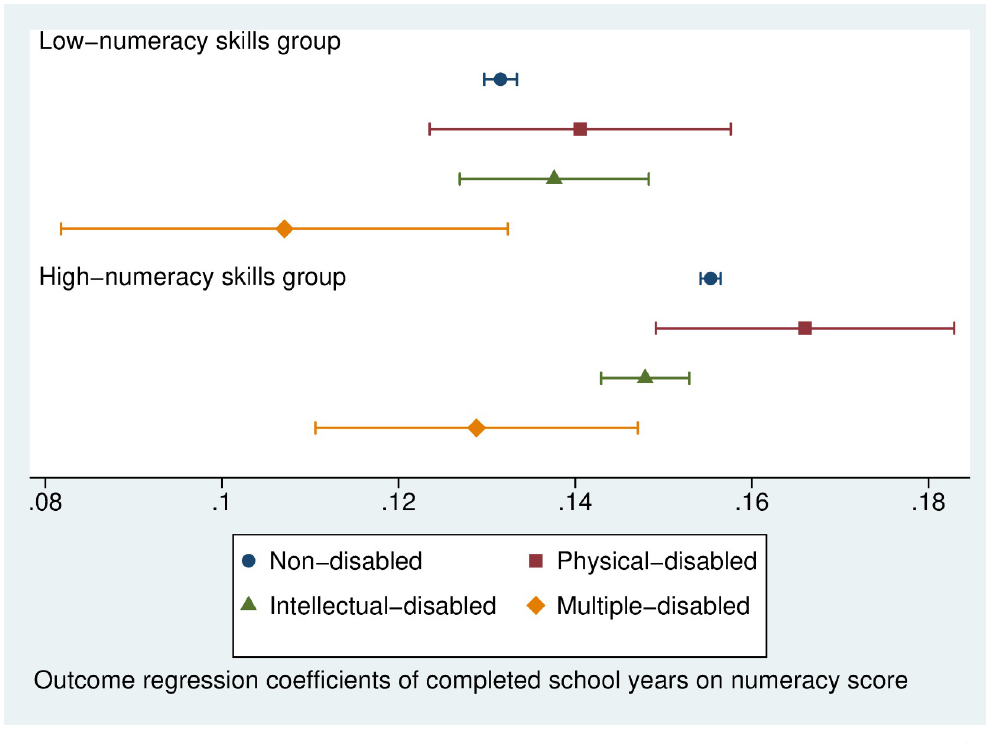
Fig 6. Outcome regression coefficients of completed school years on numeracy scores with 95% confidence intervals (IV regression on numeracy skill return to each completed school year, separate IV models for three disability types in low- and high-numeracy skills country